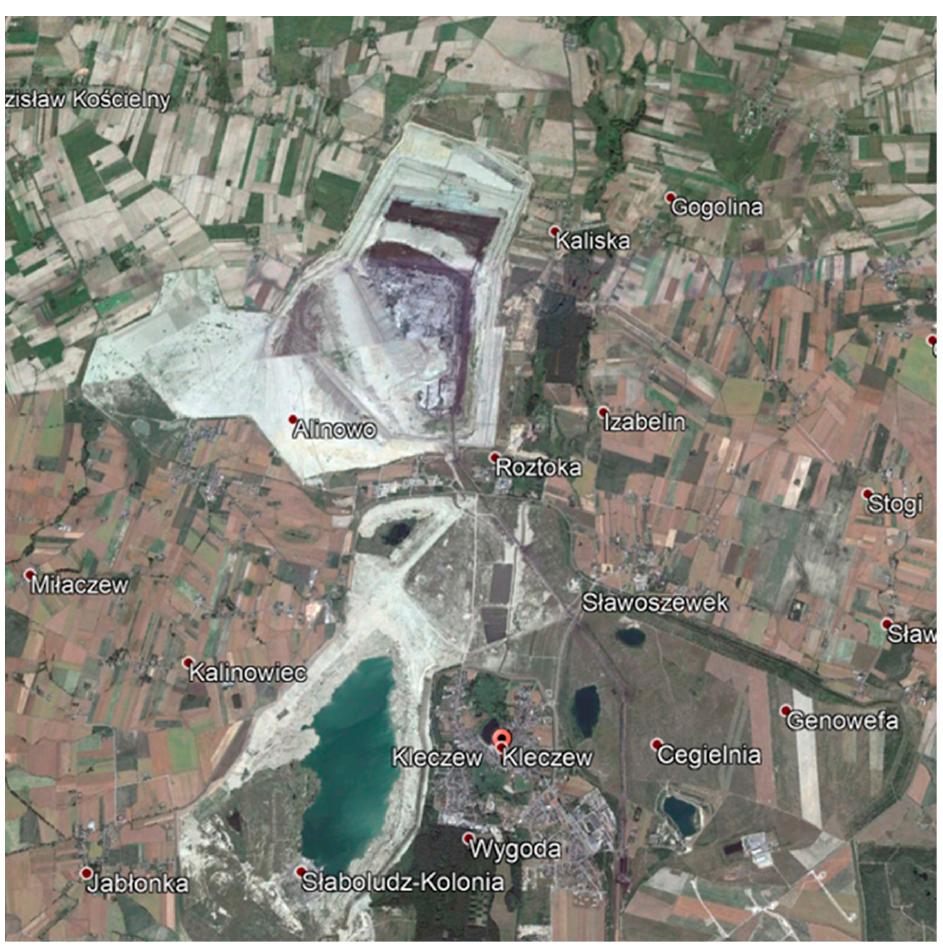
Figure 12. The Kazimierz and Jó ź win open pits in 2015 (source: Google Earth).